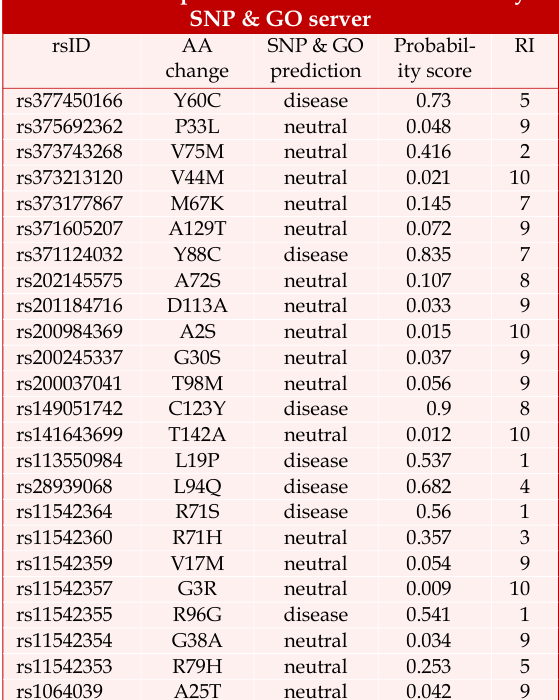
List of nsSNP predicted as disease associated